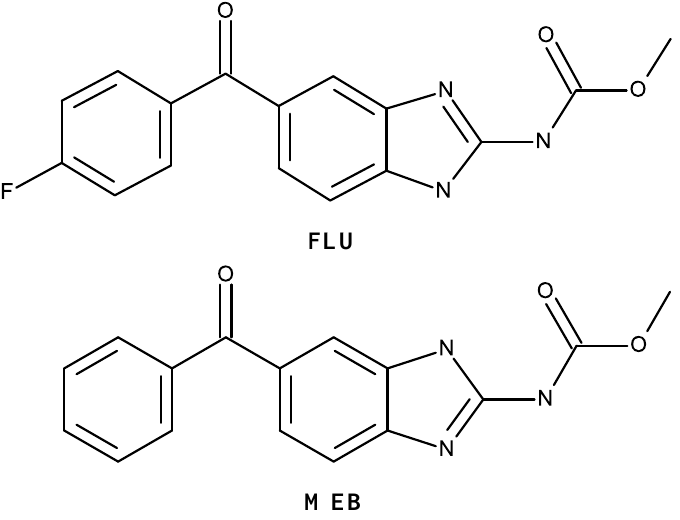
Figure 1. Chemical structures of FLU and MEB.